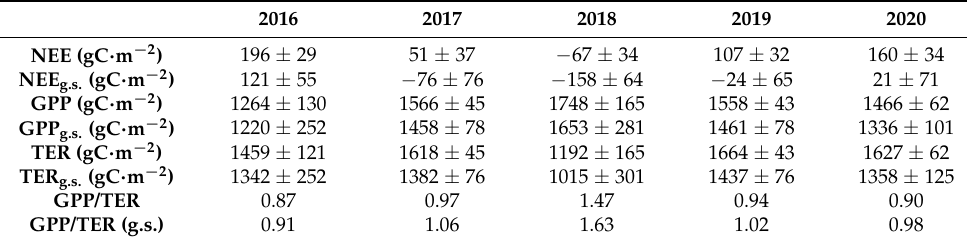
Table 3. Annual and growing season (g.s.) sums of the net ecosystem exchange (NEE), gross primary production (GPP), and total ecosystem respiration (TER) with the uncertainty estimates associated with random error in the measured fluxes: u*—threshold estimation, gap-filling, and flux partitioning procedures ( ± SD) as well as GPP/TER ratio in 2016–2020. Growing season sums were calculated for the long-term average growing season: 12 April–11 October in the 1991–2020